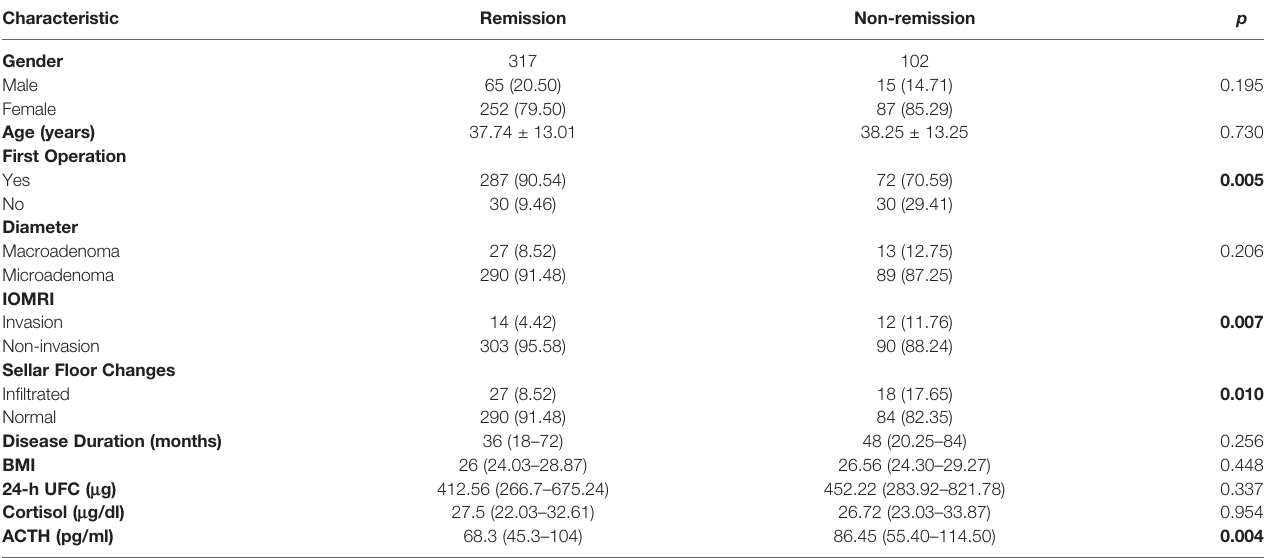
Bold values in this table represent statistical signi fi cance (P <